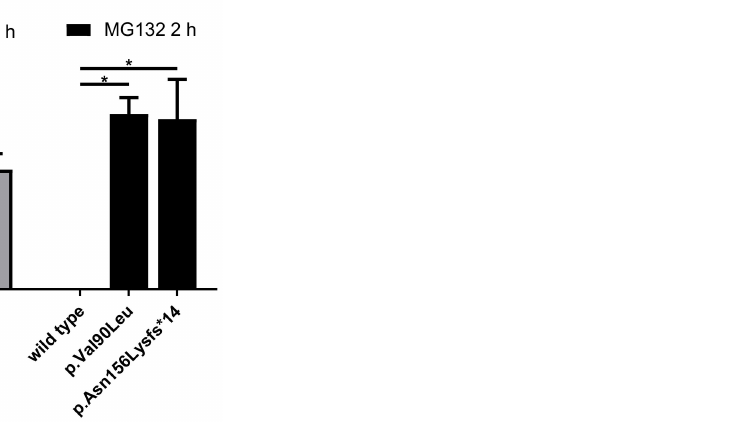
Figure 7. Translated cells with inclusions compared to those without (* p < 0.05, ** p < 0.01, n =